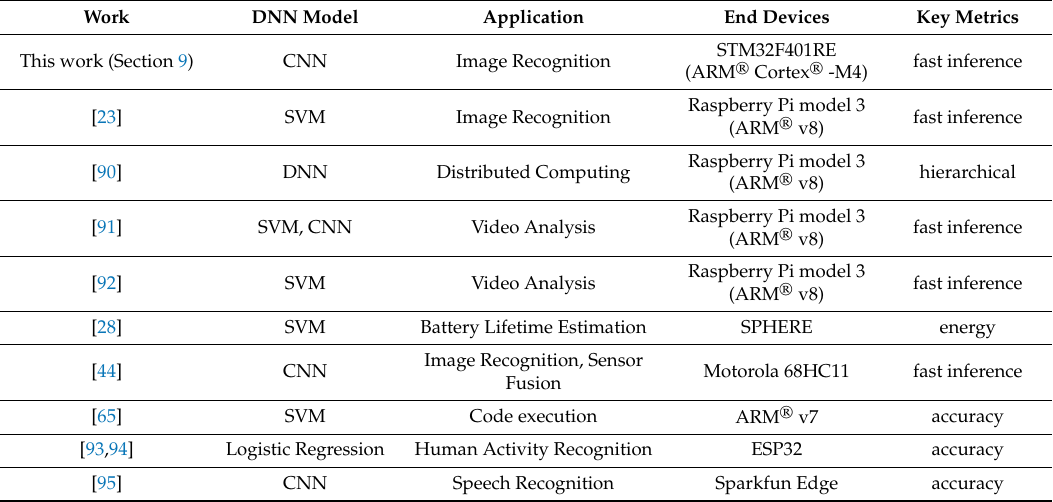
Table 1. Hardware used for Internet of Things (IoT) devices that implement edge computing. Work DNN Model Application End Devices Key